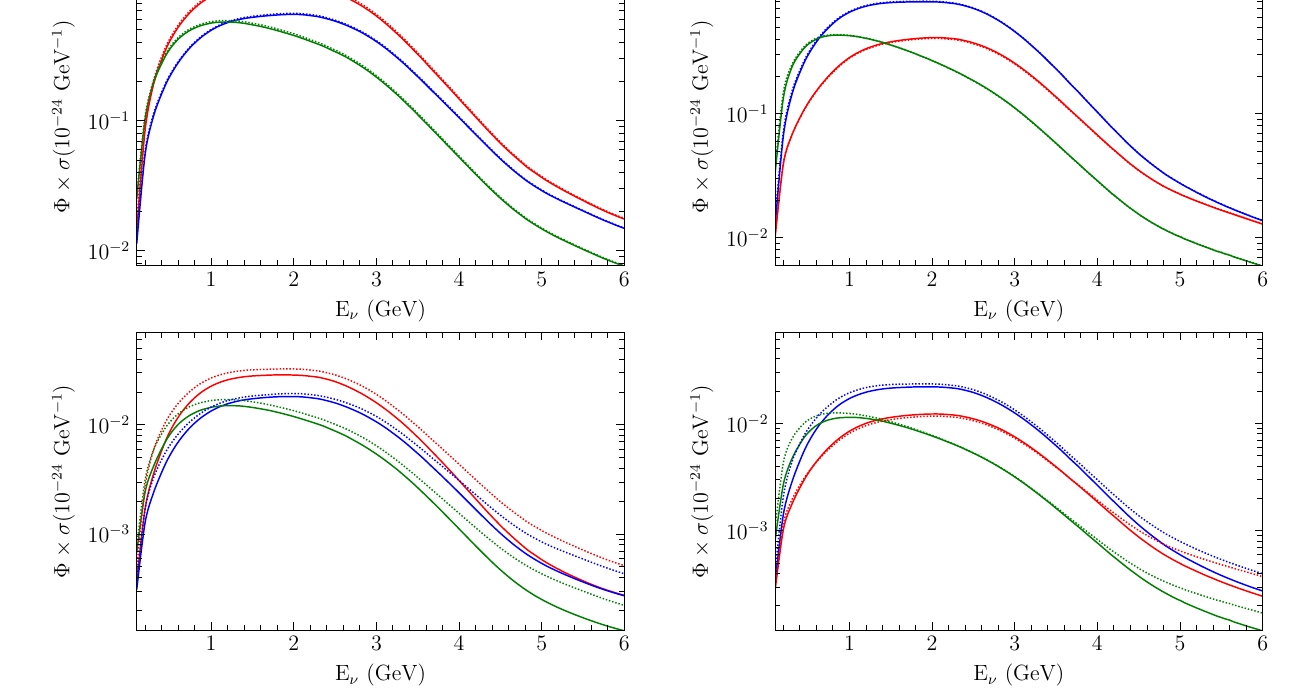
Fig. 3 The VD contribution to ((cid:9) × σ) , for ν e appearance, at DUNE (top) and ANDES (bottom). The left (right) column shows results con- sidering the FHC (RHC) flux. Solid (dashed) lines include (do not include) matter effects. We show results for x 31 → 1 with scalar and